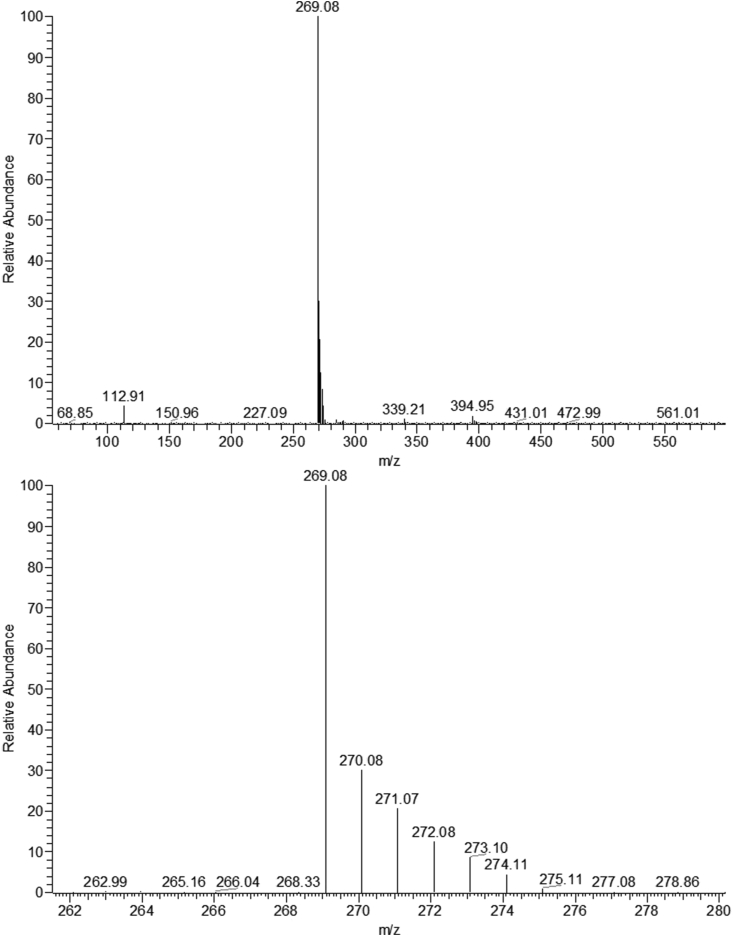
The spectrum of Deuterated apigenin and the spectrum of D-AP specified around M/Z = 270.